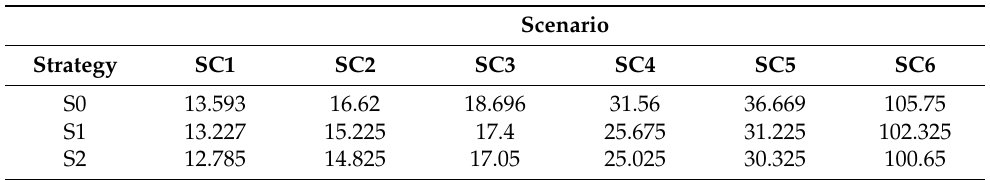
Table 4. Total fuel consumption ( Fuel T ( lpm ) under 60 s cycle) under different scenarios and PF-based strategies used to test the performance of the PV/FC/ESS system.